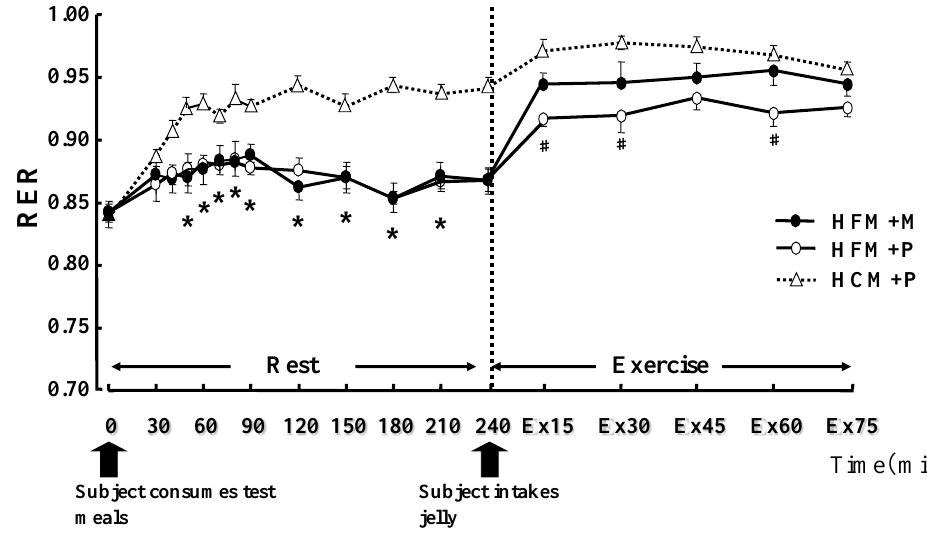
Figure 2. Changes in the Respiratory Exchange Ratio (RER) at rest and during exercise. * indicates when high-fat meal with maltodextrin (HFM + M) and high-fat meal with placebo (HFM + P) values were significantly lower than high-carbohydrate meal and placebo (HCM + P) values ( p < 0.05). # indicates when HFM + P was significantly lower than HCM+P ( p < 0.05). Data are shown as mean ± S.E.